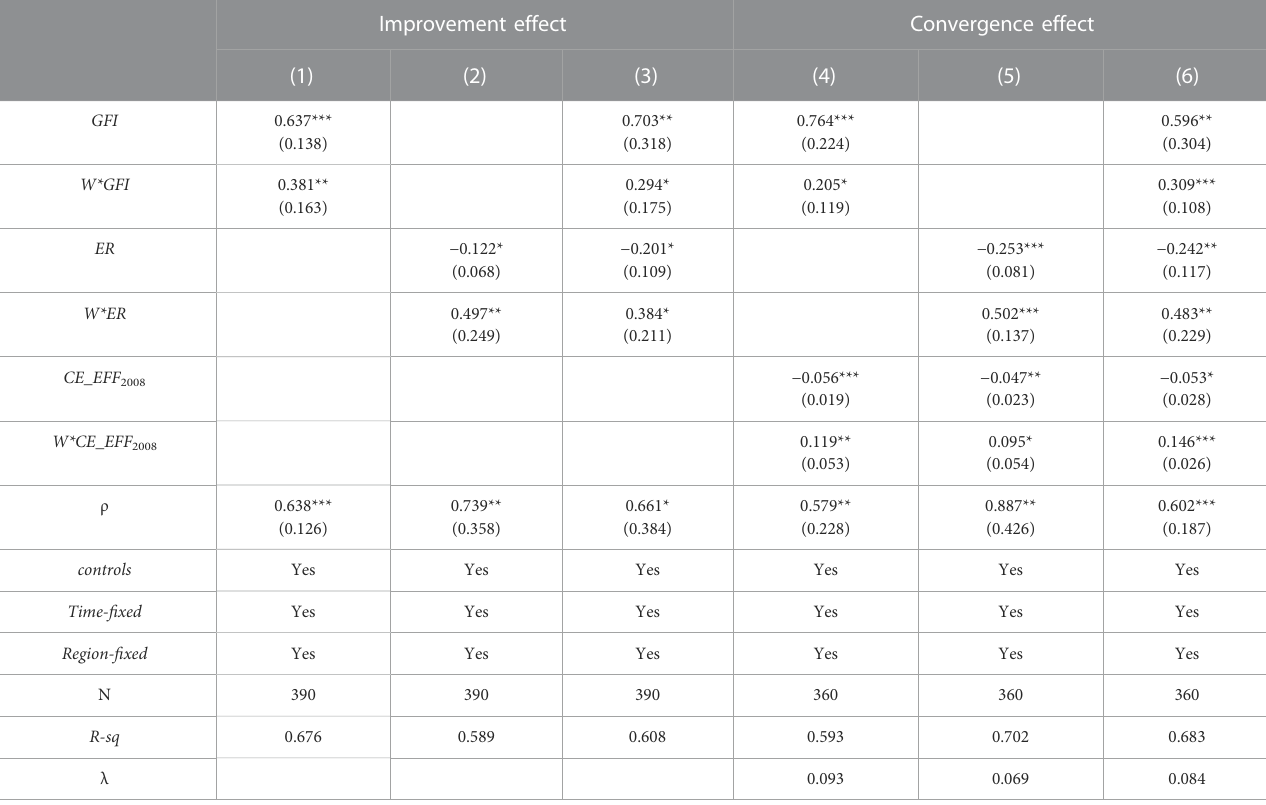
TABLE 8 Estimation results of the SDM